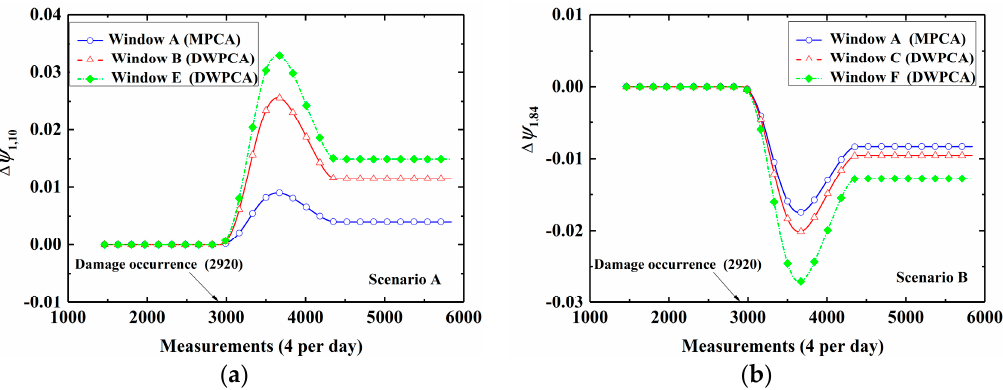
Figure 17. Evolution of the corresponding CEVs for different space windows: ( a ) Scenario A; ( b ) Scenario B.